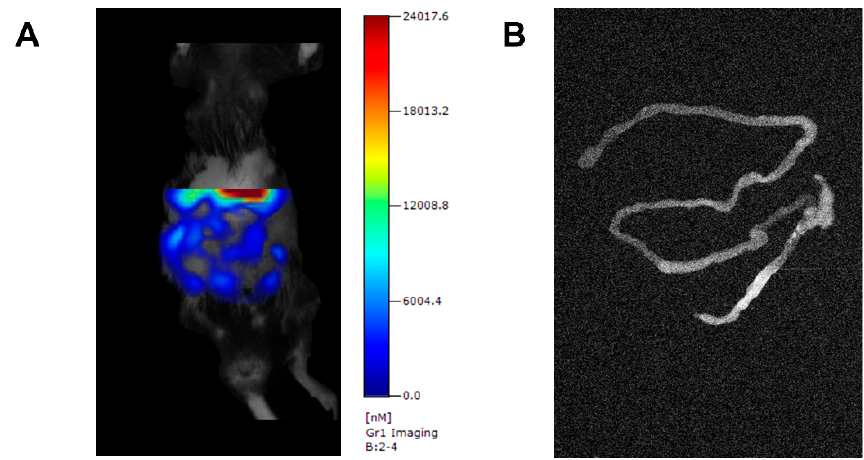
Figure 5. Ex vivo validation of tracer specificity. To verify the colonic origin of the tracer signal, in vivo FMT scans in colitic mice injected with the specific probe (anti mouse Gr-1) were followed by ex vivo planar fluorescence scans of explanted intestines (n = 5). Representative images are shown depicting in vivo FMT scans of colitic mice with color-coded fluorescence intensity corresponding to the extent of inflammatory infiltrate ( A ) and subsequent ex vivo fluorescence scans ( B ) with fluorescence intensity (brightness) corresponding to the extent of inflammatory infiltrate.